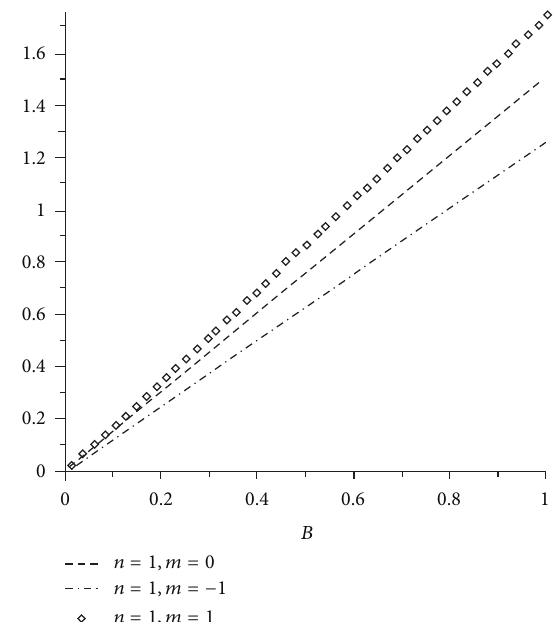
Figure 4: The energy eigenvalues versus 𝐵 (𝑀 = 1)